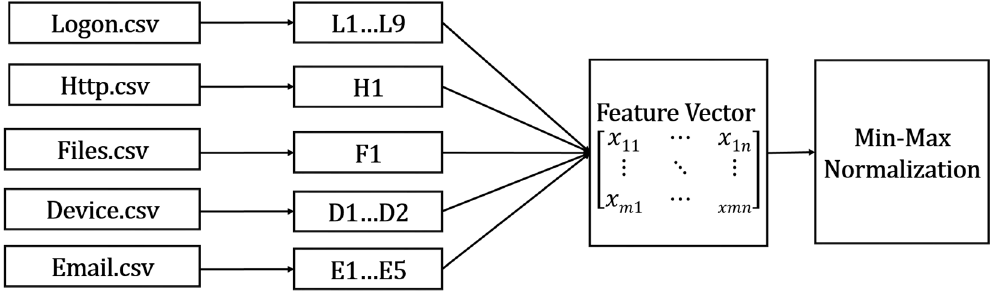
Figure 2. Feature extraction from log files.